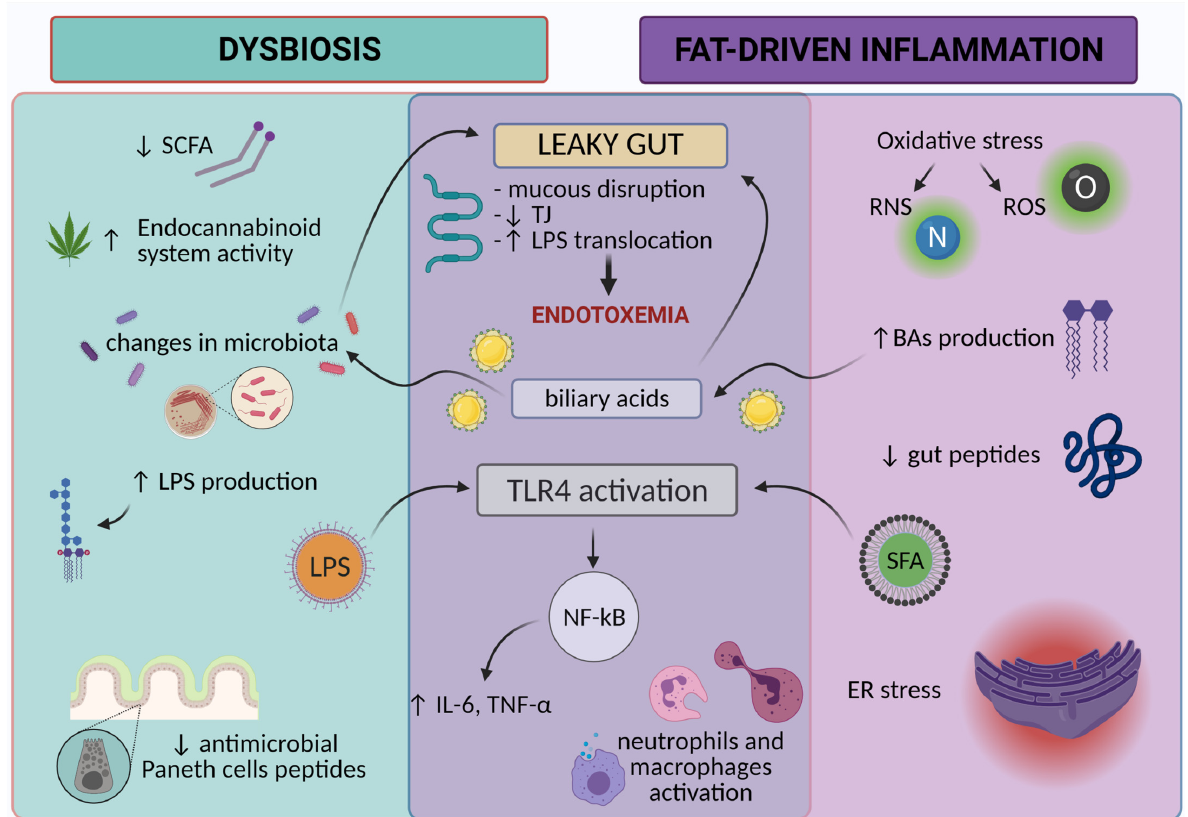
Figure 2. Western diet-associated pathologies. SCFA, short-chain fatty acids; LPS, lipopolysaccharide; TJ, tight junctions; TLR4, toll-like receptor 4, NF- κ B, nuclear factor kappa-light-chain-enhancer of activated B cells; IL-6, interleukin 6; TNF- α , tumor necrosis factor-alpha; RNS, reactive nitrogen species; ROS, reactive oxygen species; ER, endoplasmic reticulum; SFA, saturated fatty